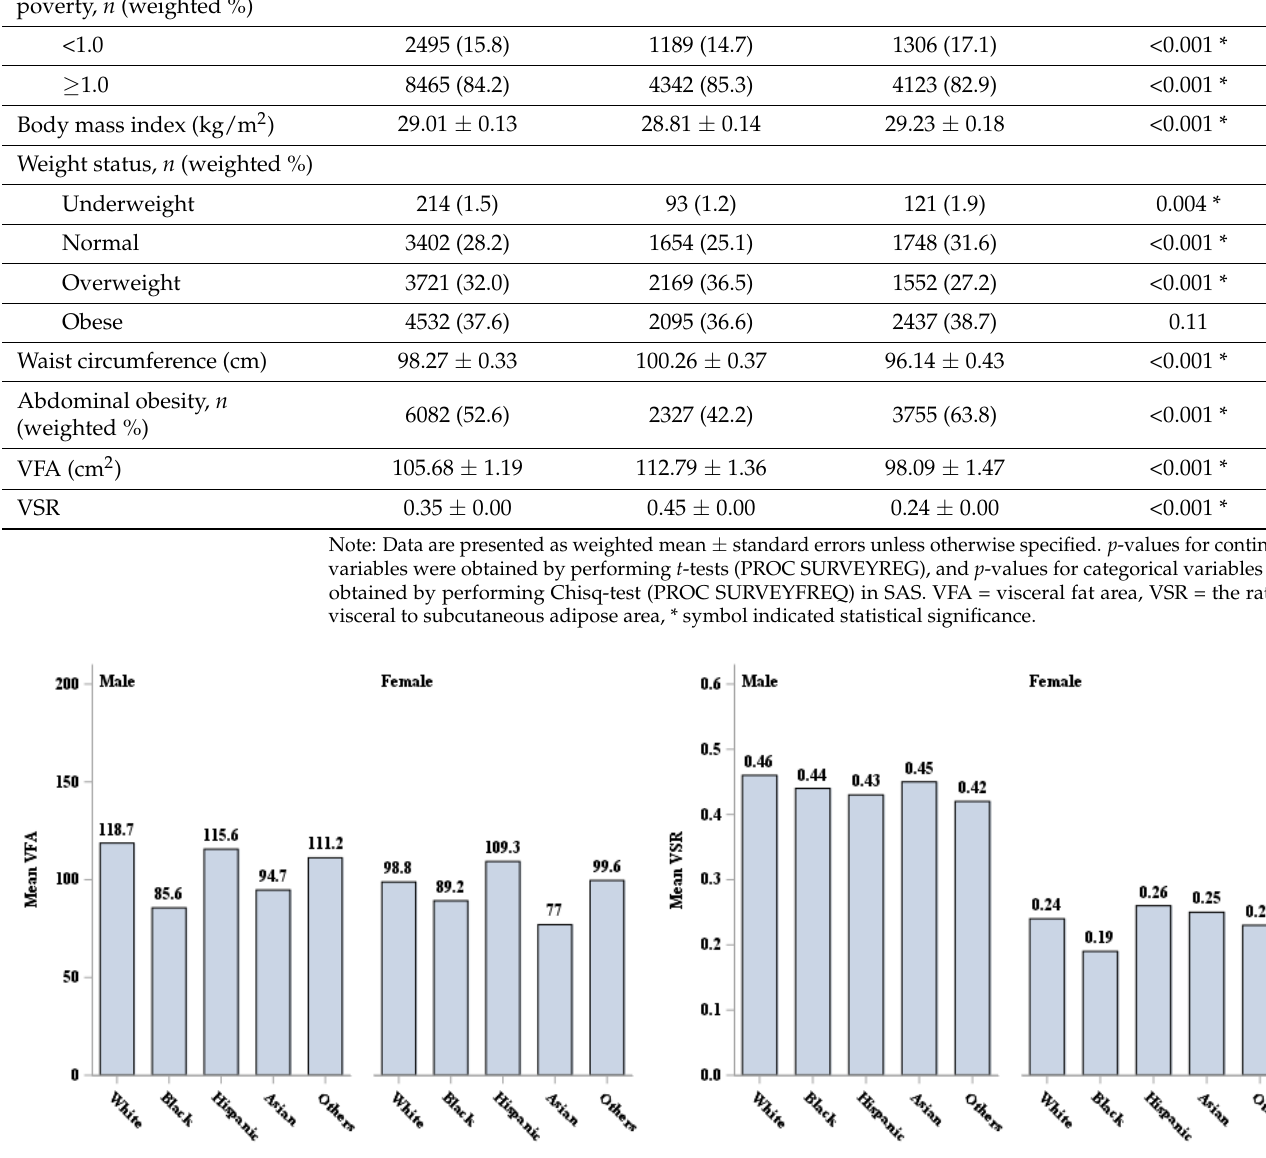
Figure 1. VFA (cm 2 ) and VSR description by sex and race/ethnicity. VFA = visceral fat area, VSR = visceral to subcutaneous adipose area ratio.